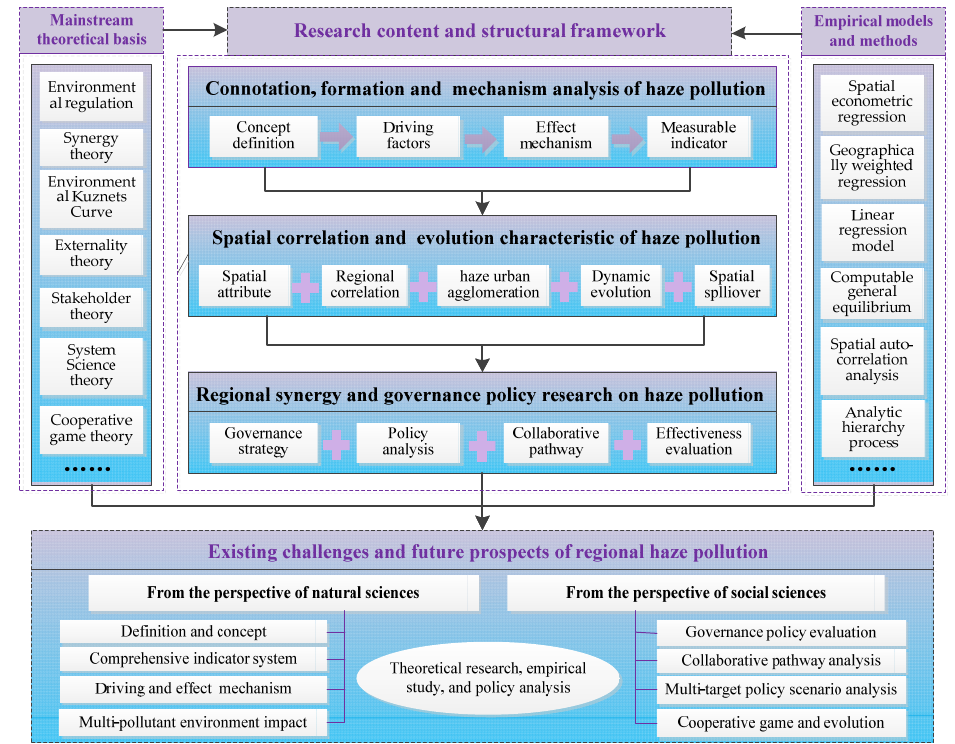
Figure 2. The overall framework of this review article.